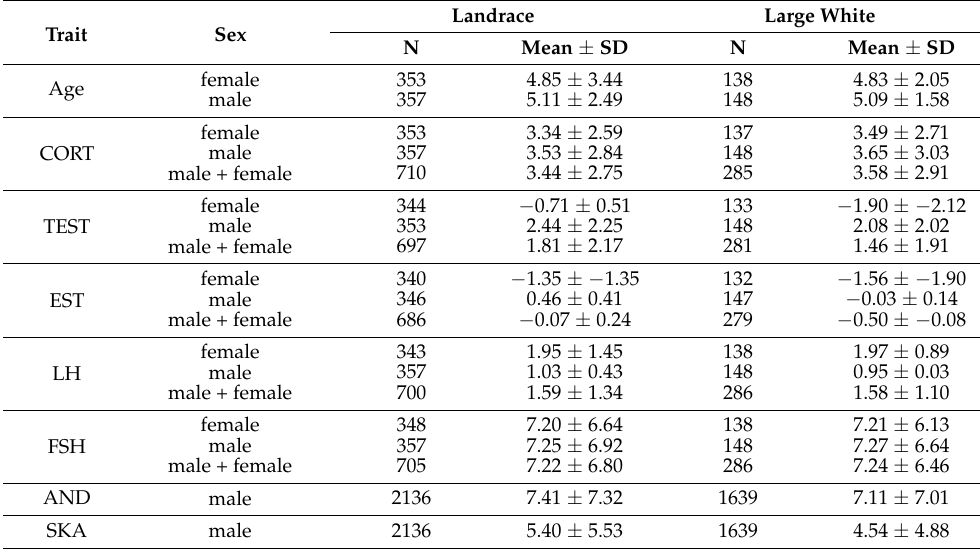
Table 2. Descriptive statistics of the analyzed traits (log-transformed). Landrace Large Trait Sex